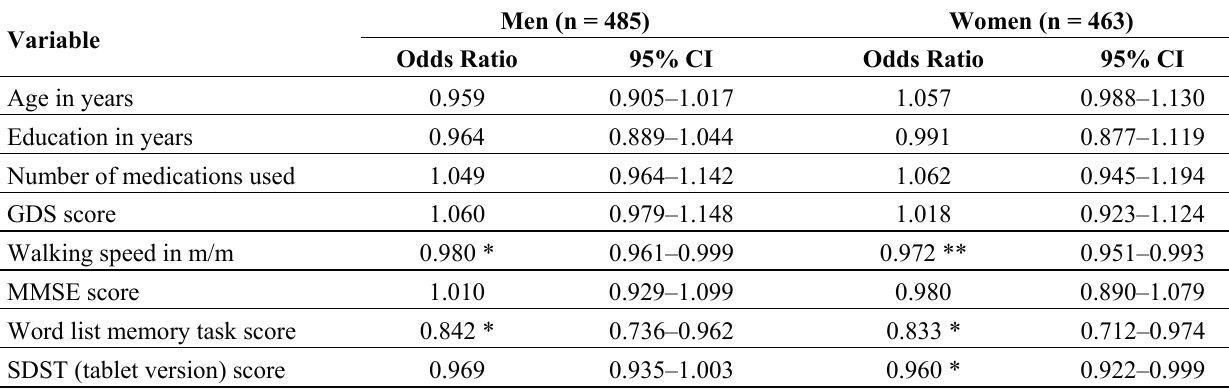
Table 4. Baseline characteristics and cognitive function associated with subsequent self-reported IADL limitation in logistic